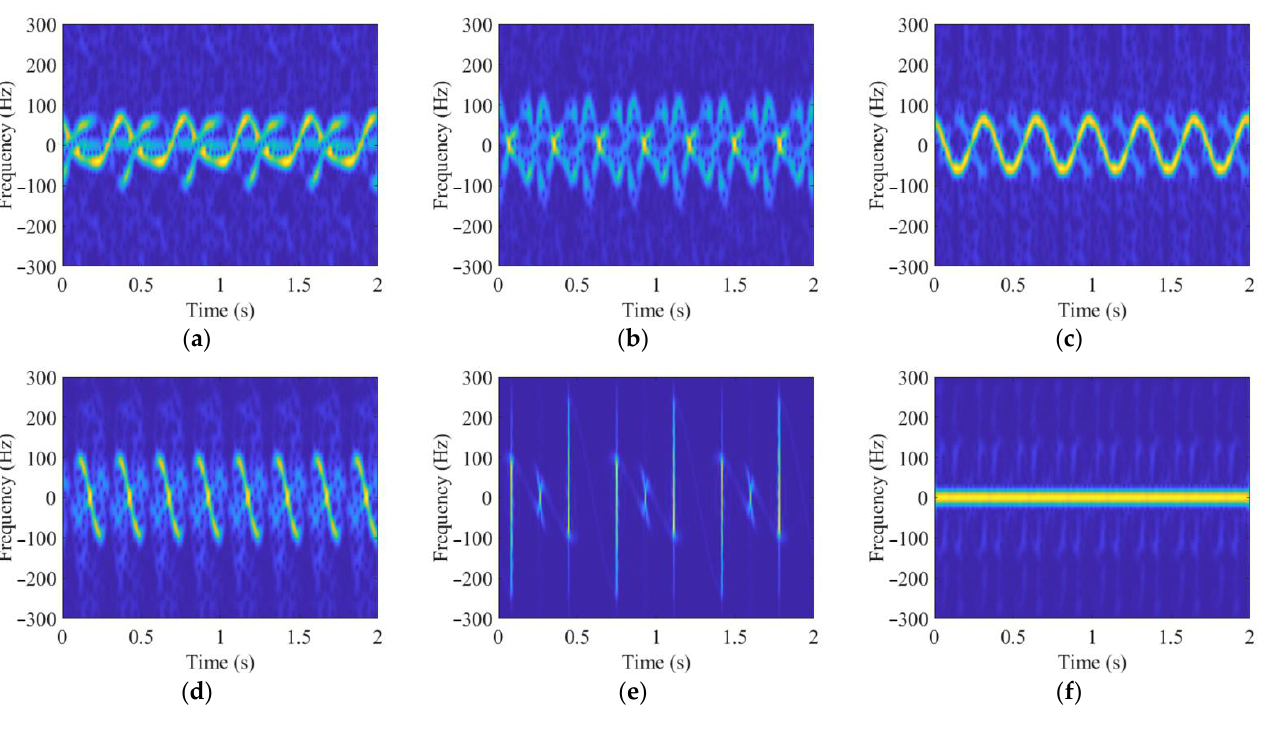
Table 2. Performance comparison of various methods.